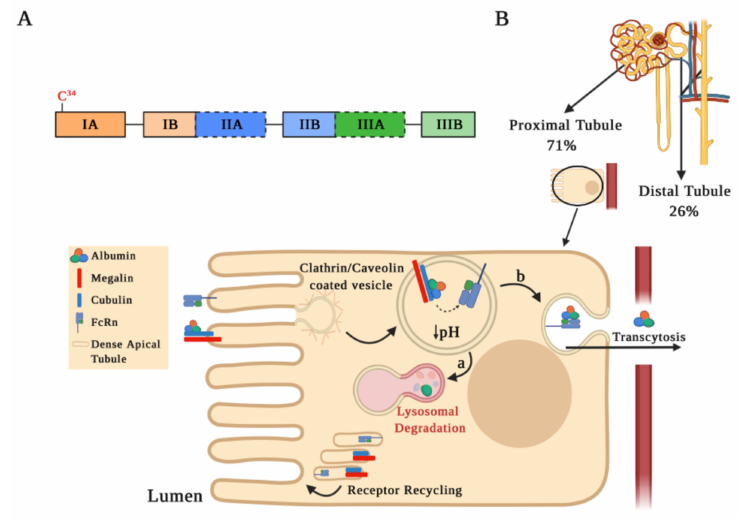
Figure 1. Albumin structure and its tubular reabsorption. ( A ) Schematic drawing of the human serum albumin (HSA) structure. The mature HSA presents 585 amino acids and a molecular weight of 66.5 kDa, containing three homologous α -helical domains (I, II, and III), each comprised of two sub-domains A and B. Each sub-domain is represented by a rectangular bar with a unique color. The two Sudlow’s sites, high affinity binding sites for different molecules on HSA, are marked in black dashed lines. ( B ) Albumin is partially filtered in the glomeruli and reabsorbed by receptor-mediated endocytosis into proximal (71%) and distal tubule cells (26%). This schematic representation shows albumin internalization and its degradation in the proximal tubule. Albumin binds to the megalin– cubulin complex receptor and is directed into clathrin-coated vesicles for endocytosis. Following endocytosis, endosomal acidification occurs, which causes albumin dissociation from the megalin– cubulin complex, leading albumin to bind to the neonatal Fc receptor (FcRn). Finally, albumin is transferred to the lysosomal compartment for degradation (step a) or for the transcytotic pathway (step b), while the receptors may be recycled through dense apical